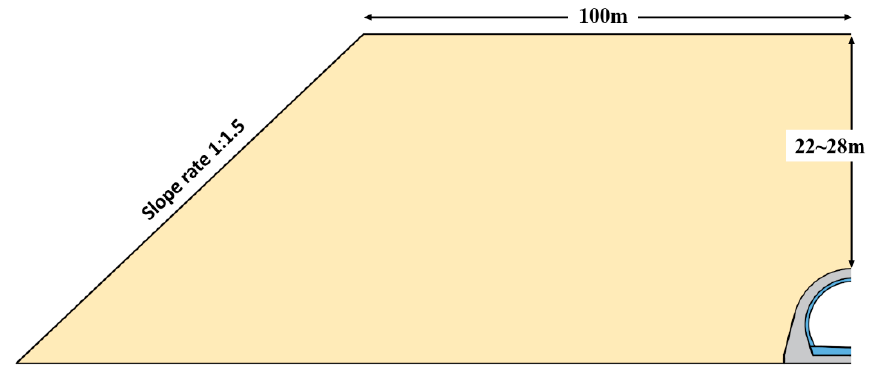
Figure 3. Design details of the tunnel. ( a ) Cross section of the tunnel and the concrete dam foundation; ( b ) Profile view of the whole project.